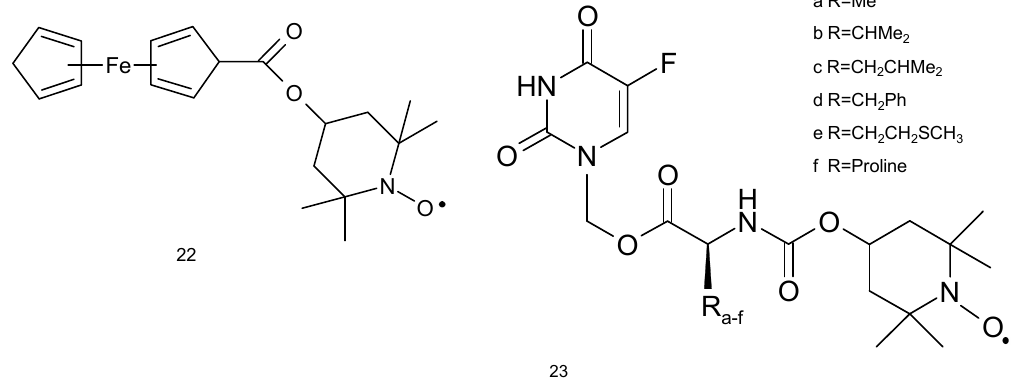
Figure 7. Nitroxides as anticancer agents: ( 22 ) FC-Tempo, ( 23 ) spin-labelled fluorouracil derivatives. Fluorouracyl is widely used for the treatment of many tumors such as colon and rectal cancer, breast cancer, gastrointestinal cancers (including anal, esophageal, pancreas and gastric cancers), head and neck cancer, basal cell cancer of the skin and actinic keratosis (squamous cell), neuroendocrine tumors, thymic cancers, cervical cancer, bladder cancer and hepatobiliary cancers.